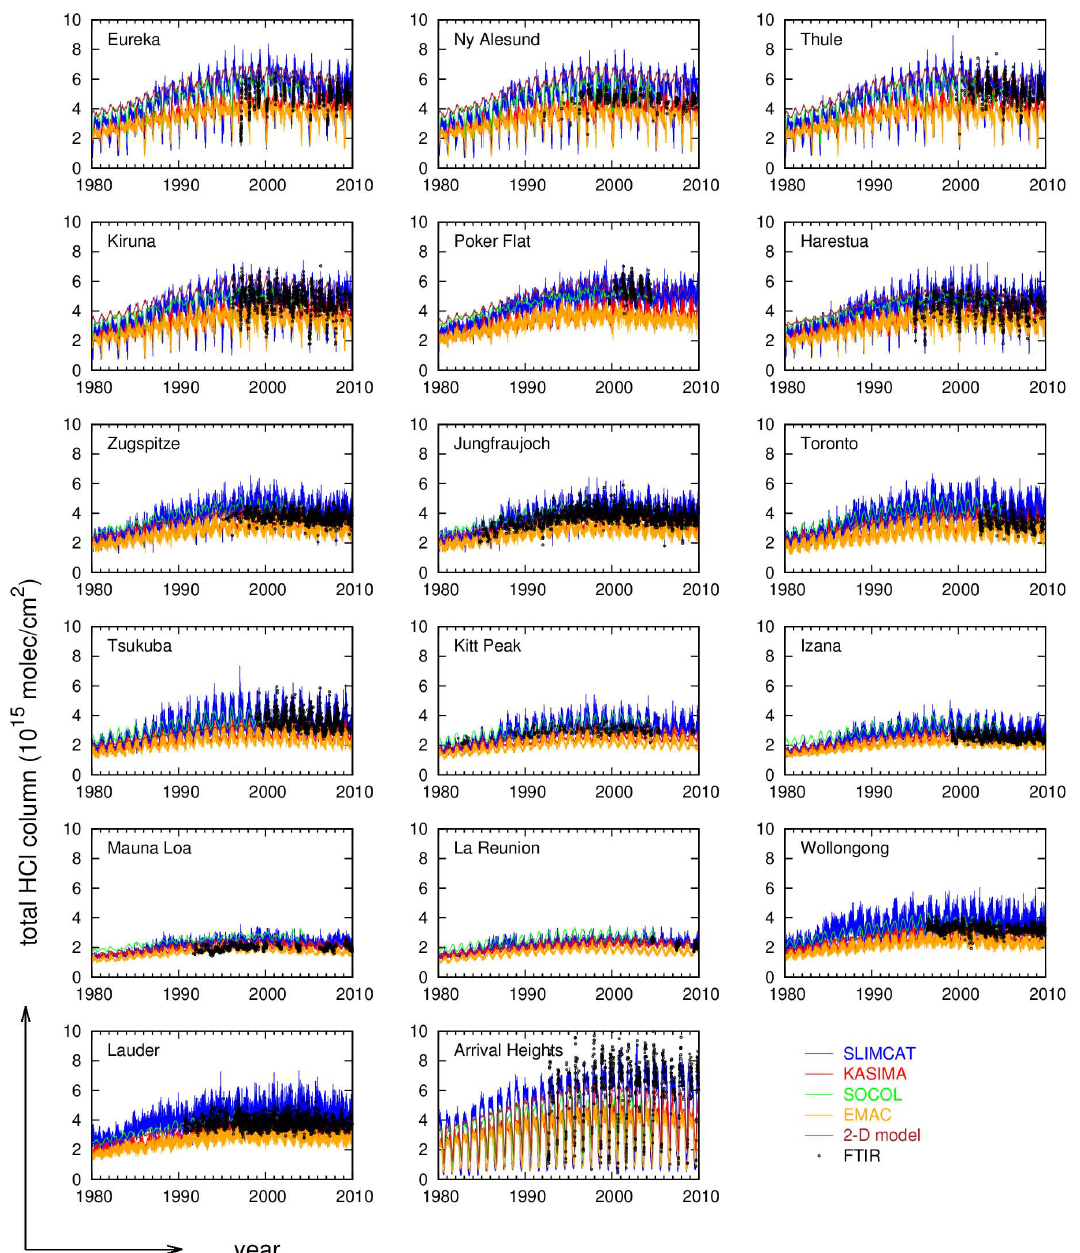
Fig. 3. Time series of HCl total column abundances in molecules per cm 2 at the different sites as measured by FTIR (black dots) and simulated by SLIMCAT (blue line), KASIMA (red line), SOCOL (green line), EMAC (orange line), and Bremen 2-D model (brown